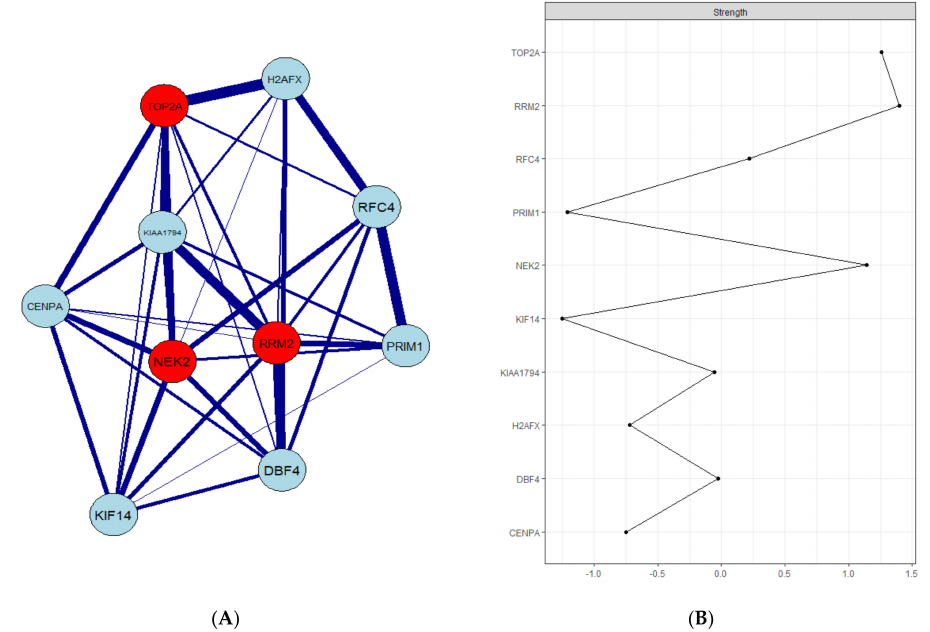
Figure 2. Co − expression network of the top ten genes of the black module: ( A ) each node in the co − expression network denotes a gene; nodes with red signify the hub genes, and the middle line represents the link between genes. ( B ) The connection strength of the top ten